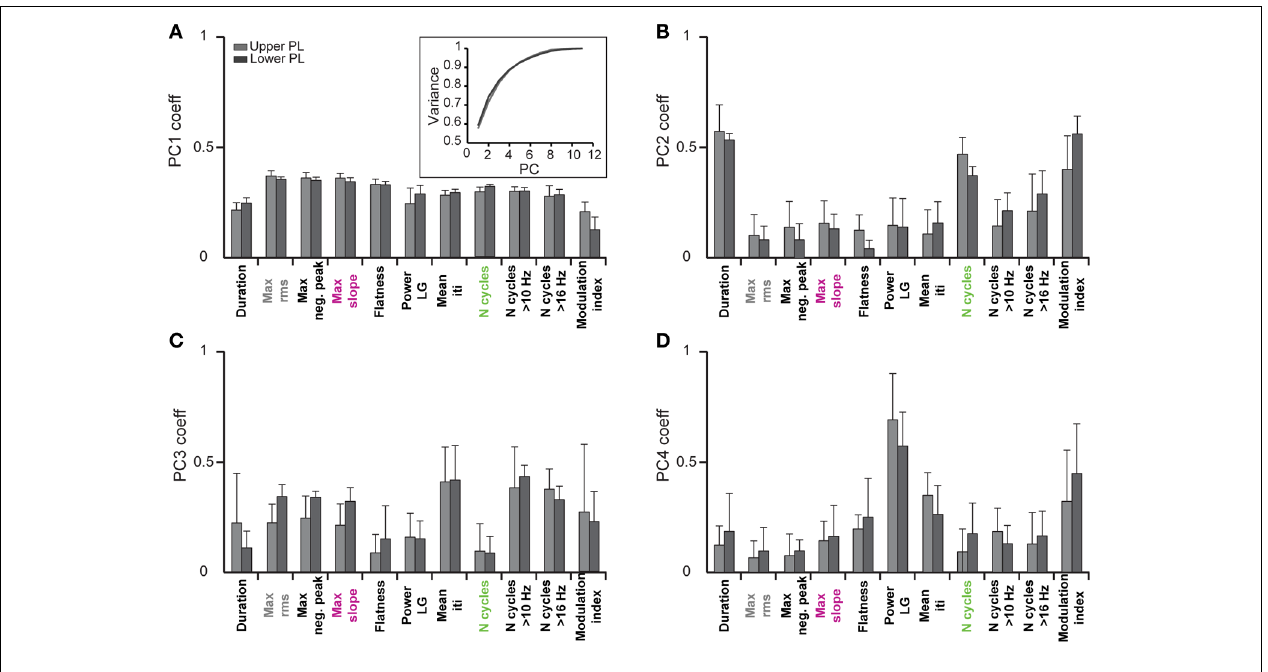
FIGURE 3 | Contribution of single features to the clustering of oscillatory events by principal component analysis. Bar diagrams show the average PCA coefficients ( n = 6 pups) that relate the